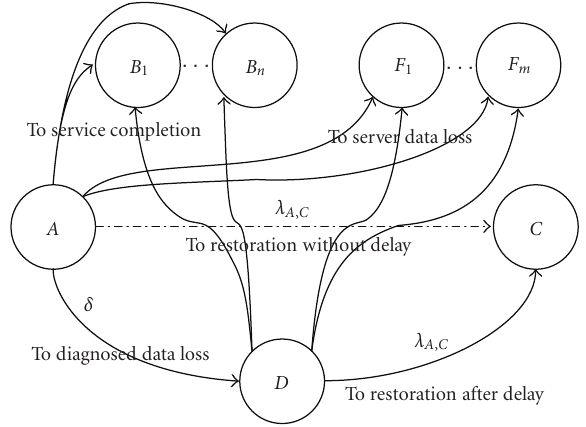
Figure 7: Control action delay modeling with a single-stage delay